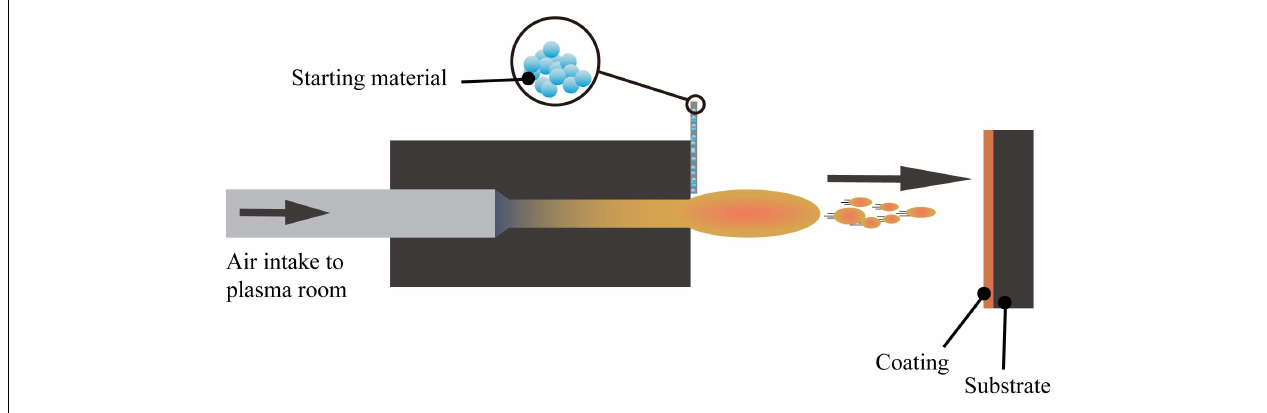
FIGURE 4 | The layout of the plasma spraying setup (Viana et al.,